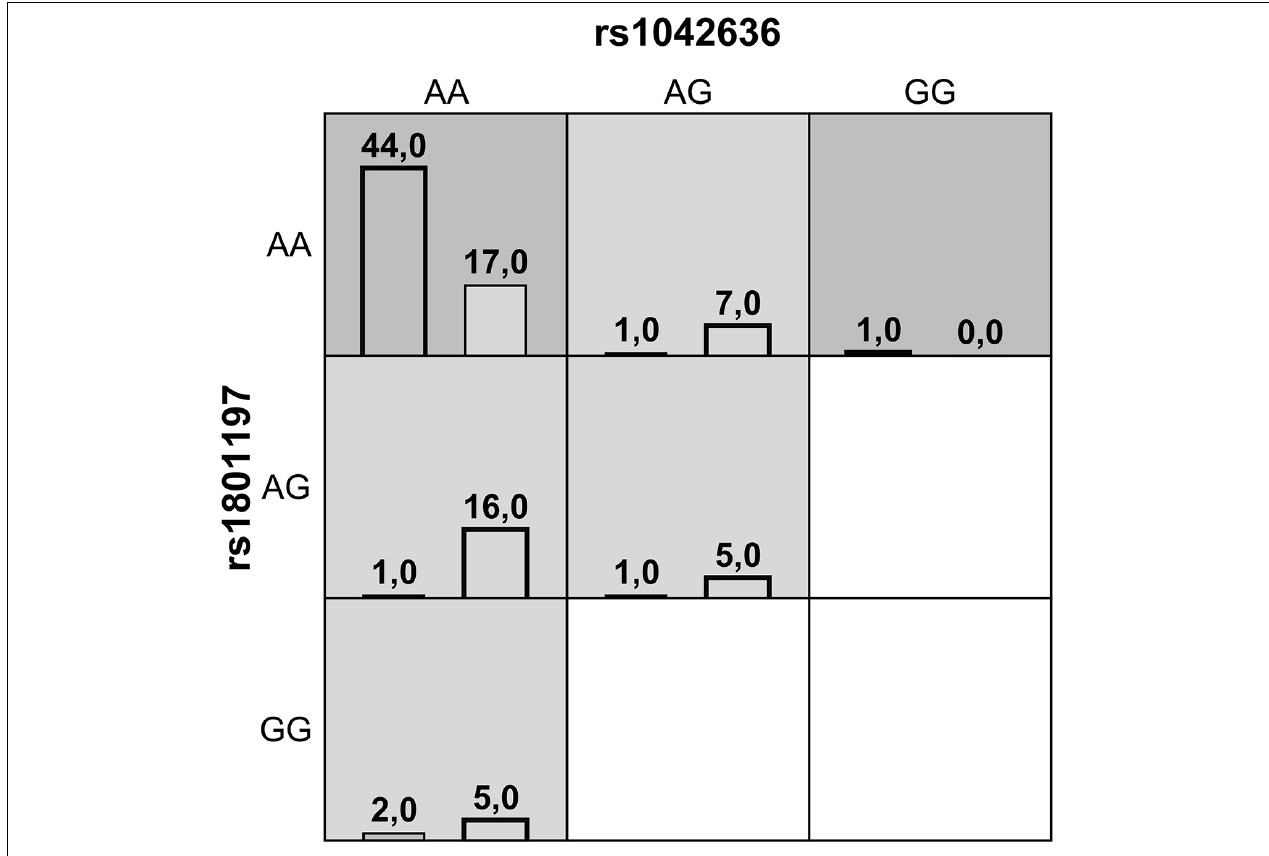
FIGURE 1 | A summary of the best two-way gene-gene interaction analysis by multifactor dimensionality reduction for 9 genotypes [rs1042636 ( CASR ) and rs1801197 ( CALCR )] associated with increased risk of KSD. The dark shading box represents high-risk combinations and the light shading box shows low-risk combinations. The left and right columns represent the absolute number of the cases and controls,